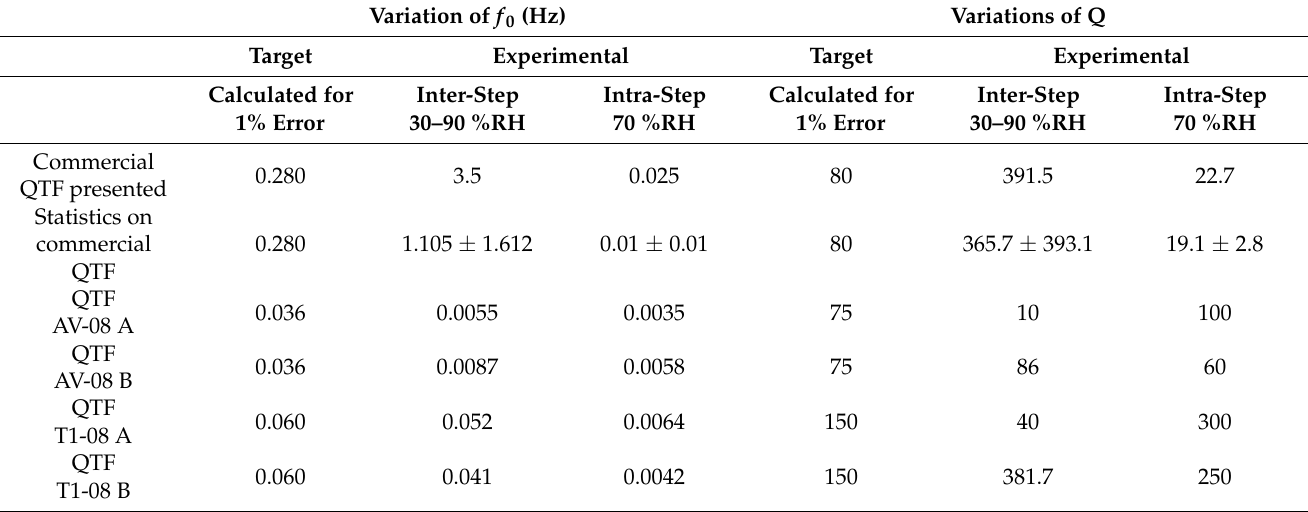
Table 2. Comparison of measured variation of f 0 and Q to the related calculated variation leading to 1% error on the measured QEPAS signal. The measured variation of f 0 and Q are obtained by varying the humidity between 30 and 90 %RH. Variation of f 0 (Hz) Variations of Q Target Experimental Target